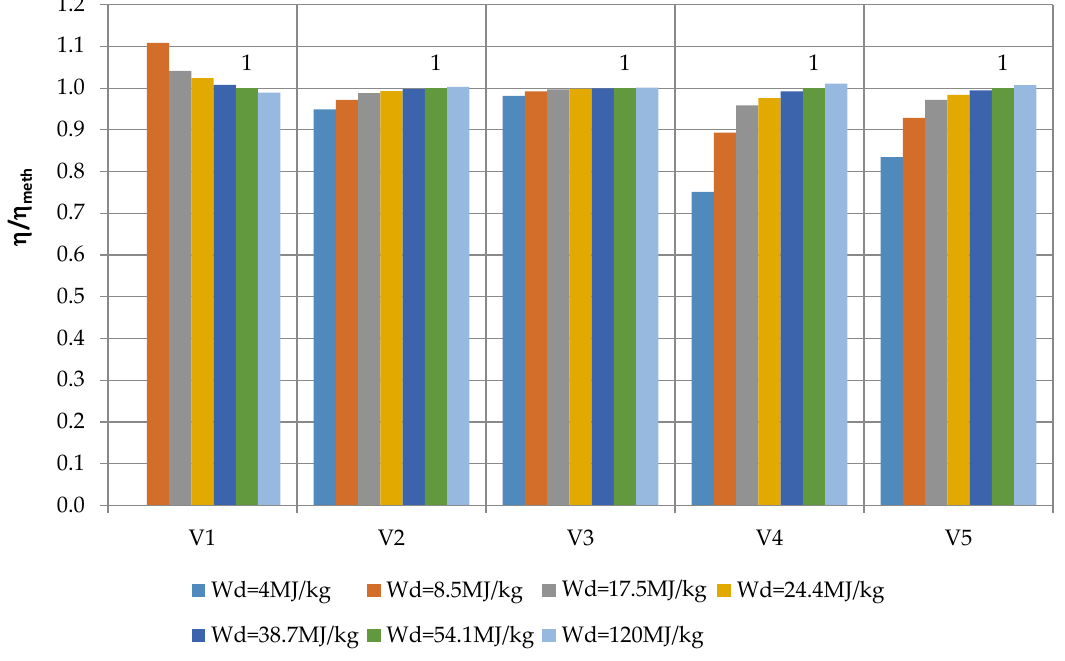
Figure 12. Collective diagram of the influence of the structure of the cycle and calorific value of fuel on its e ffi ciency in relation to the variants of cycles with methane as a fuel.